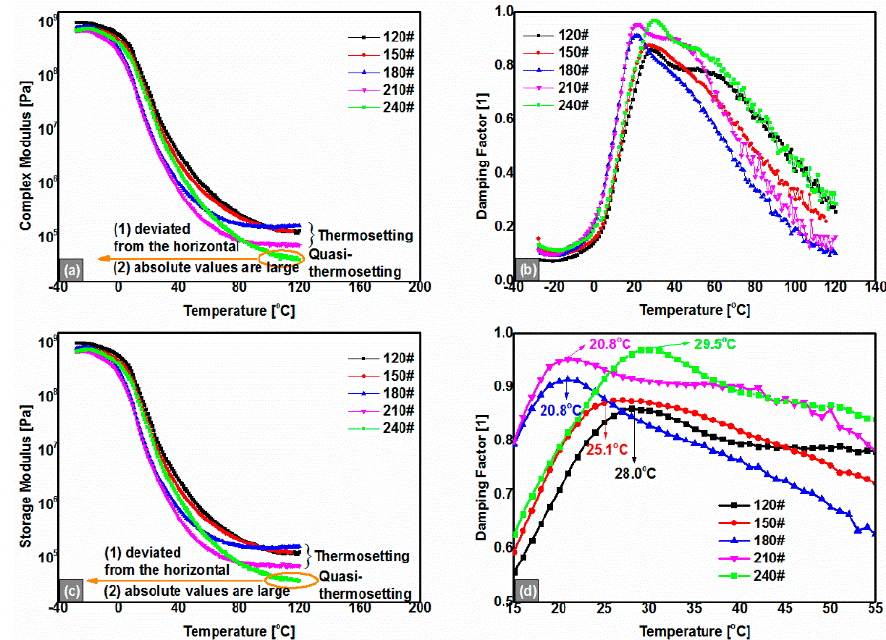
Figure 4. Temperature sweep results of the anhydrides-cured bimodal REACs with different asphalt content; ( a ) Complex moduli (| G *|) vs. temperature, REACs evolved from thermosetting to quasi-thermosetting; ( b ) Damping Factor vs. temperature; ( c ) Storage moduli (| G ’|) vs. temperature, REACs evolved from thermosetting to quasi-thermosetting; ( d ) Damping Factor vs. temperature in a narrow temperature range.